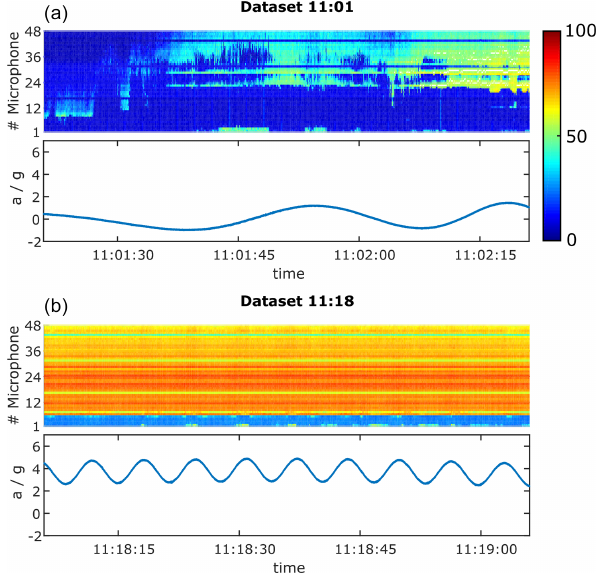
Figure 8. Detection of the transition position. (a) Start up; (b) peri- odic state. Upper row: sound-pressure level (SPL) in decibels (dB). Color map: dark blue corresponds to 0dB and red to 80dB. Lower row: local acceleration.